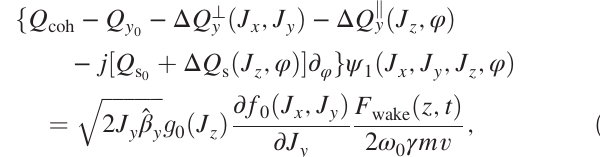
ε . The case of a linear z ¼ z